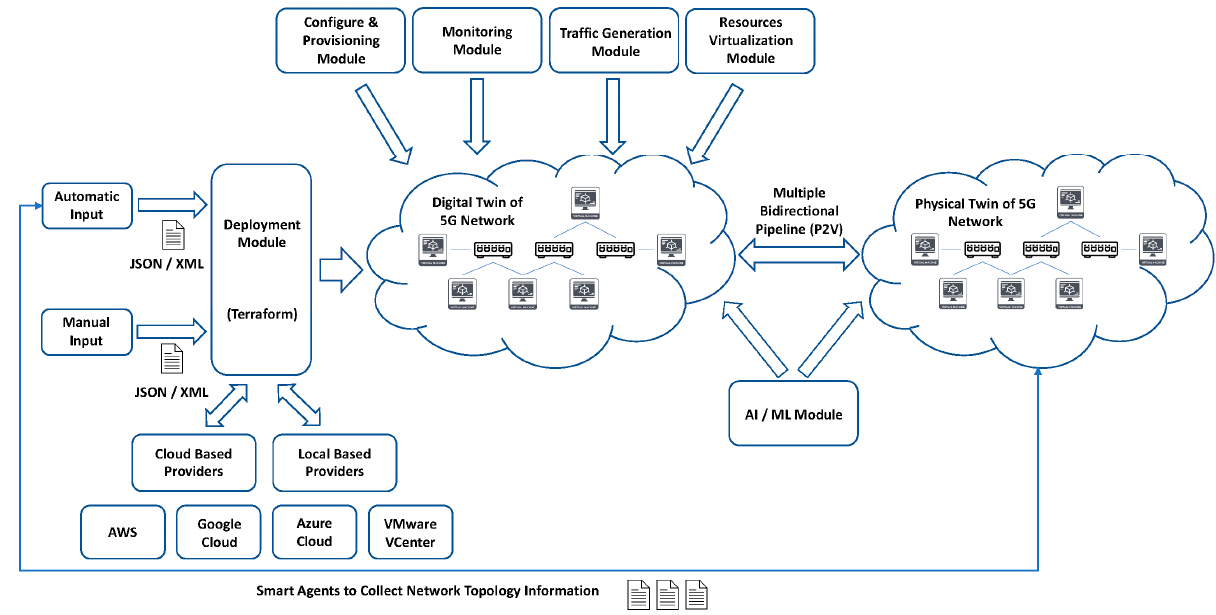
Figure 2. B5GEMINI architecture diagram.